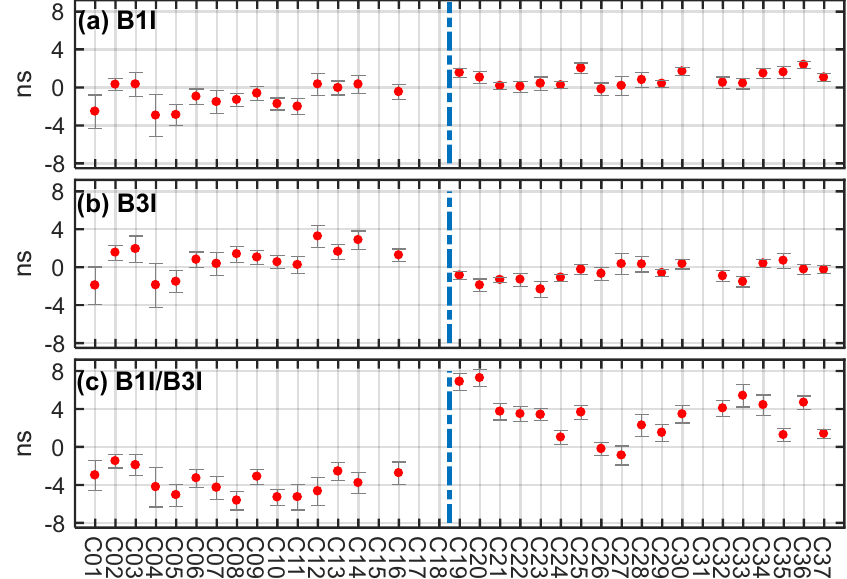
Figure 5. Estimated bias at B1I ( a ), B3I ( b ), and B1I/B3I ( c ) frequencies. The error bar stands for the standard deviation at each station. The BDS-2 and BDS-3 satellites are separated by the dashed line.